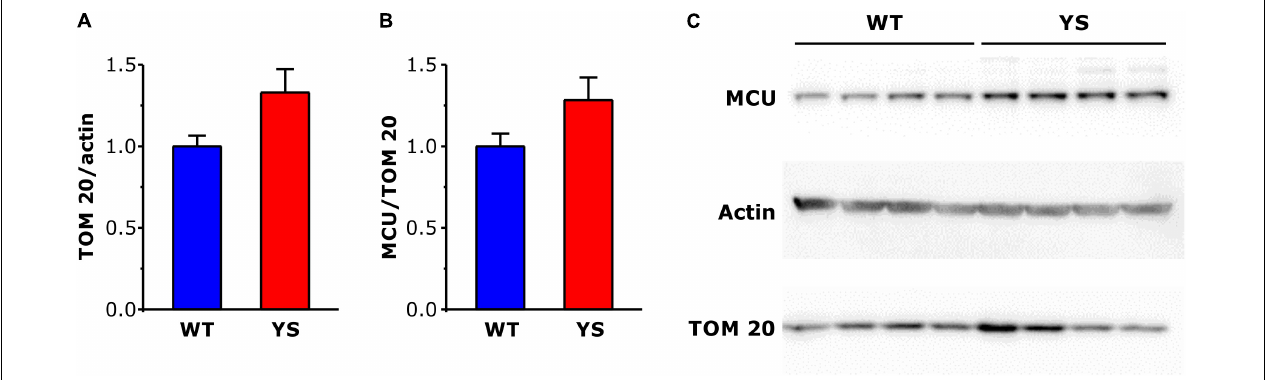
FIGURE 4 | Expression levels of mitochondrial proteins TOM20 and MCU in FDB muscles determined by Western blot. (A,B) Bar plots of brightness area product (BAP) of the immunostained bands, showing expression levels of TOM 20 (A) in relation to α -actin taken as a loading control and MCU (B) in relation to TOM 20, taken as reference of mitochondrial volume. (C) Representative western blot gels of α -actin, TOM 20, and MCU. Data are shown as means ± SEM. Panels A and B : n = 8 in each column (four